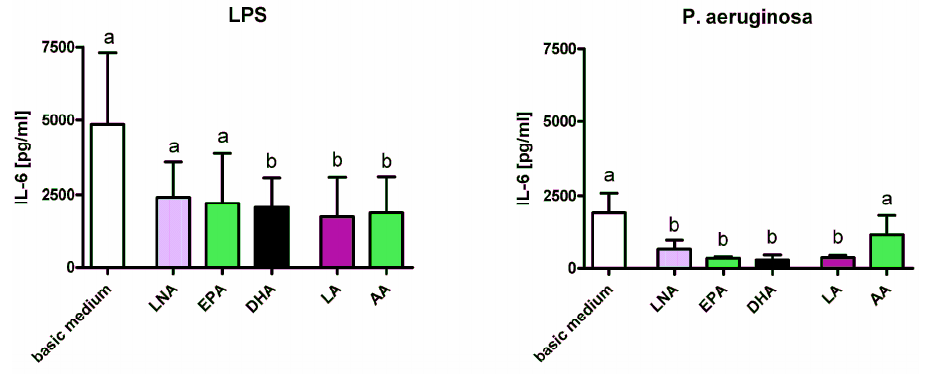
Figure 3. Concentration of IL-6 in supernatants of RAW264.7 macrophages cultured in basic medium as well as in medium supplemented with 15 µmol/L alpha-linolenic acid (LNA), eicosapentaenoic acid (EPA), docosahexaenoic acid (DHA), linoleic acid (LA) or arachidonic acid (AA) after 24 h of stimulation with LPS, P. aeruginosa ATCC 10145, R. equi ATCC 6939 and R. equi ATCC 33701 respectively. Data are mean ± SD ( n = 6). Bars denoted by different letters are significantly